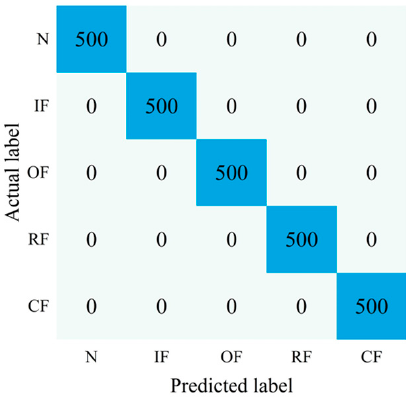
Figure 17. Classification confusion matrix of CBAM-DRN in the first experiment.